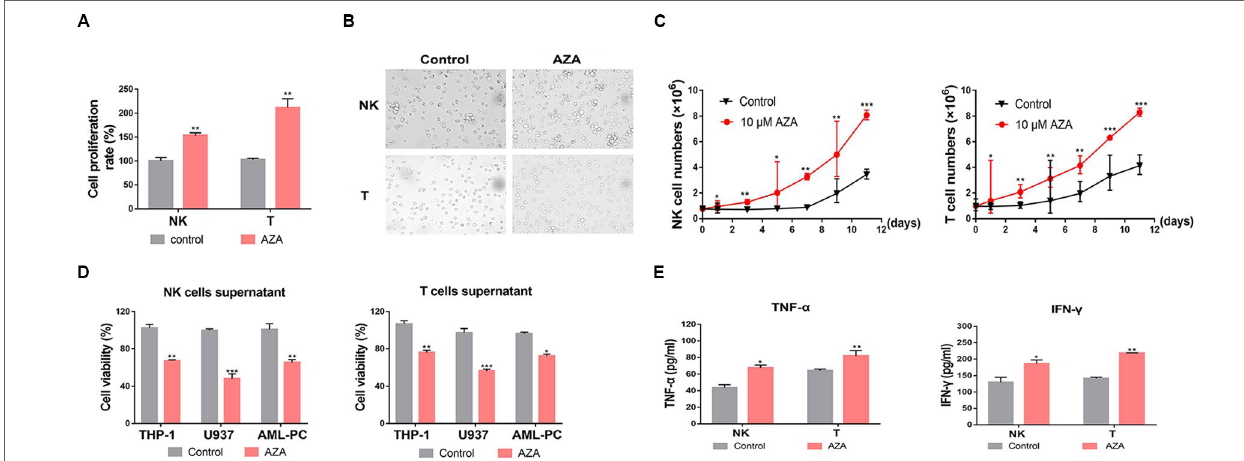
FIgUrE 2 | Azelaic acid (AZA) promotes cell proliferation of NK and T cells and increases the secretion of cytokines. (A) NK and T cells were treated with 10 μM AZA for 24 h and cell proliferation rates were measured by the CCK-8 methods. (B) NK and T cells were treated with DMSO and 10 μM AZA for 48 h and then observed under a microscope. (c) NK and T cells were treated with 10 μM AZA for 12 days. Cell proliferation rates were measured and cumulative growth curve of NK or T cells was derived. (D) NK and T cells were pre-treated with 10 μM AZA before the collected supernatants were co-cultured with the AML cell lines and the human acute myeloid leukemia (AML) patient cells. The viability of AML cells was measured by Alamar Blue assay. (E) NK and T cells were treated with 10 μM AZA for 48 h before co-culture with THP-1 cells at an E:T ratio of 3:1 for 6 h, the level of TNF-α and IFN-γ in the supernatants was measured by ELISA. Data represent standard deviations for three independent experiments. Compared to “control” group (student’s test), *P < 0.05, **P < 0.01,***P < 0.001, E:T, the ratio of effector cell and target cell; AML-PC, primary AML patient cells.